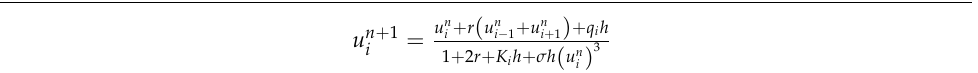
Algorithm 2: UPDF for the diffusion-reaction-radiation Equation